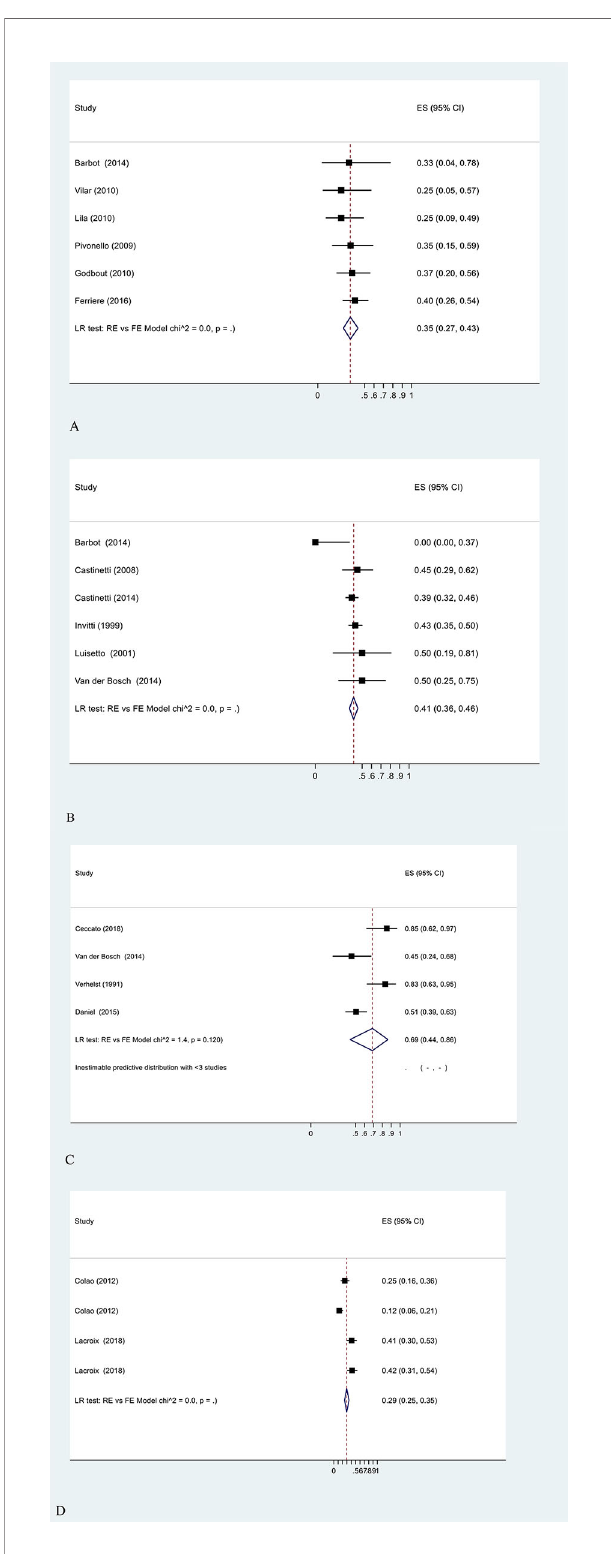
FIGURE 2 | Meta-analysis on the proportions of disease control after treatment with (A) cabergoline, (B) ketoconazole, (C) metyrapone, and (D)